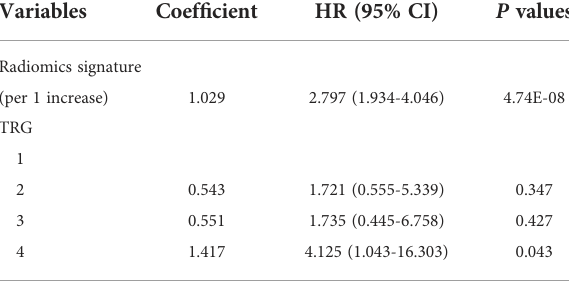
TABLE 3 Multivariate Cox regression analysis of the fi nal integrated model.